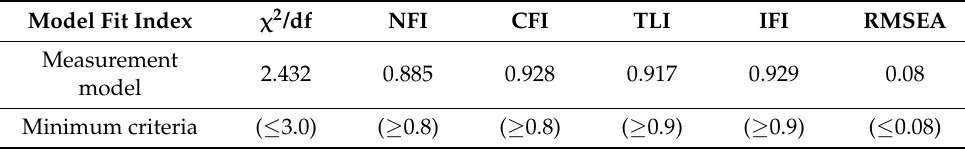
Table 9. The results of the calculation of model fit indexes.